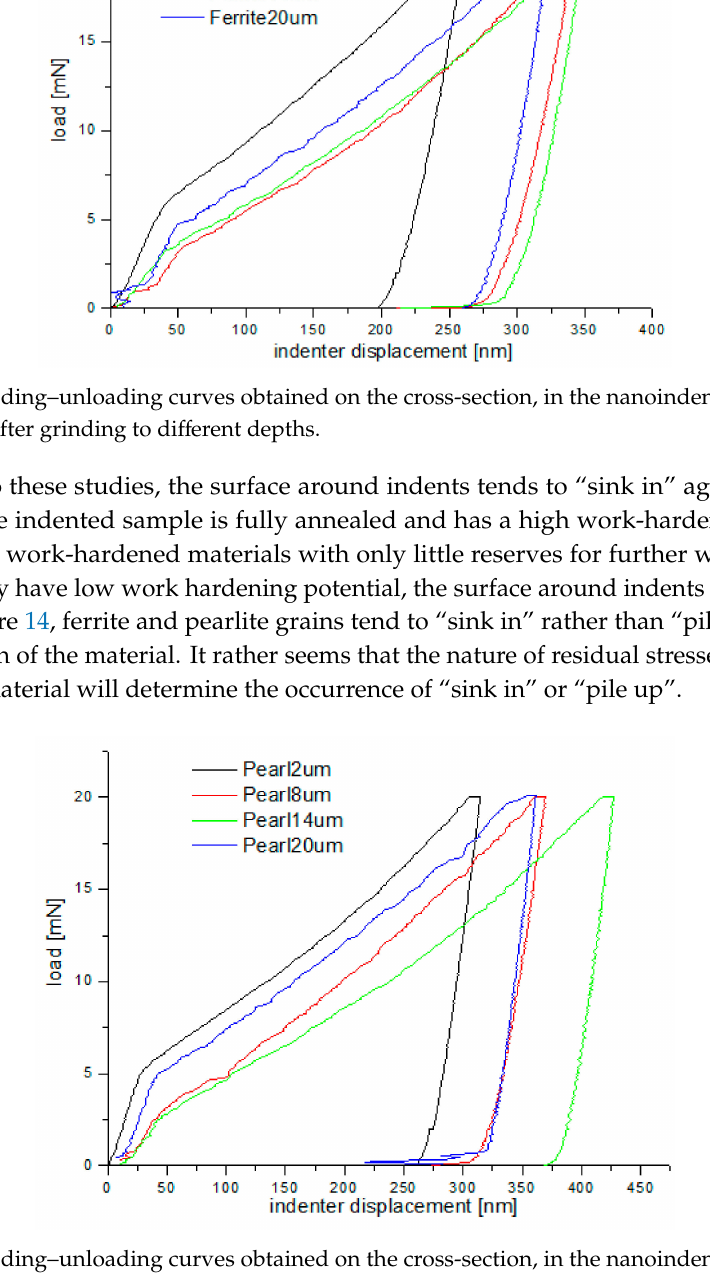
Figure 16. Loading–unloading curves obtained on the cross-section, in the nanoindentation test, for pearlite grains after grinding to di ff erent